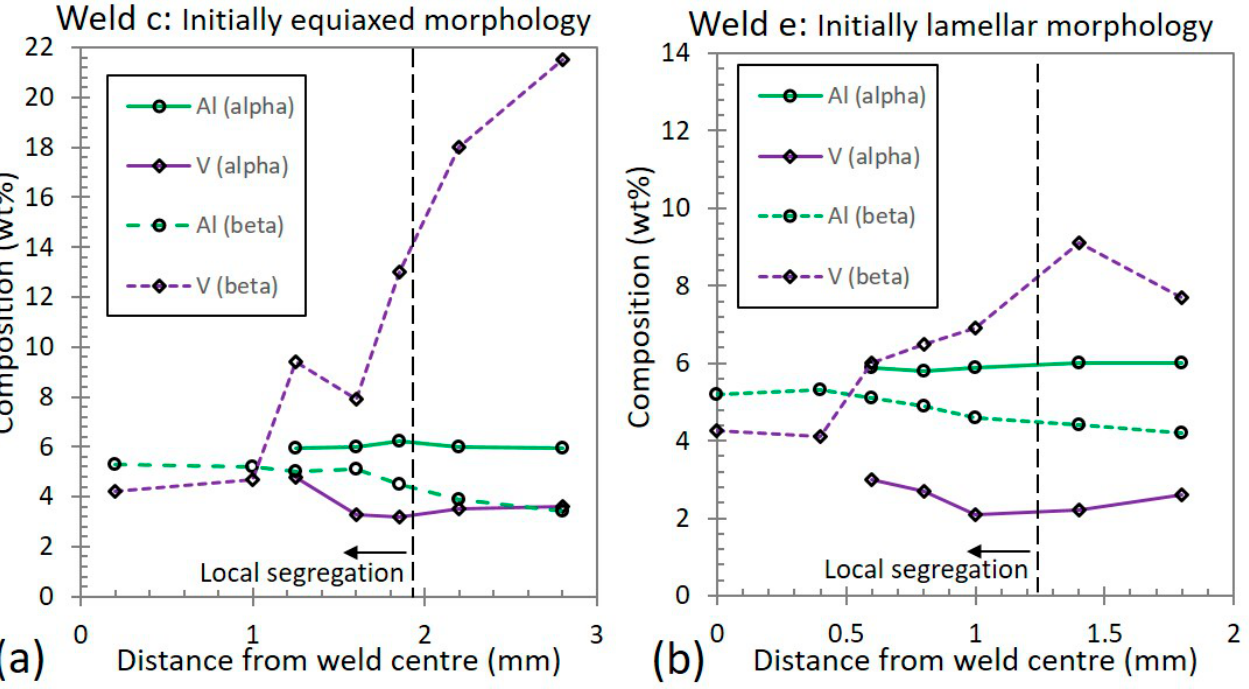
Figure 10. Measured chemical compositions of ( a ) weld c and ( b ) weld e as functions of distance from the weld path.